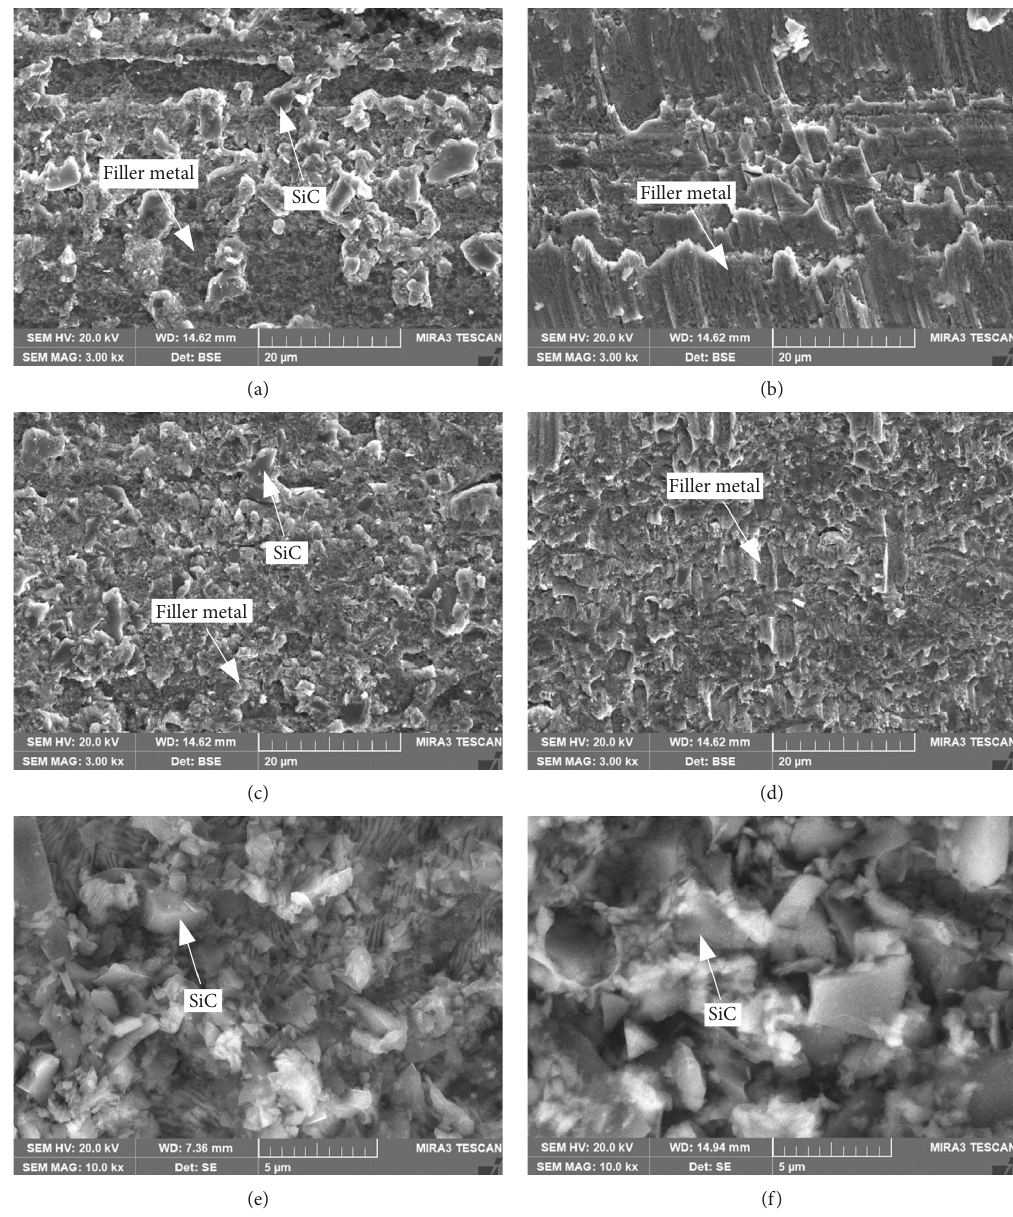
Figure 7: Fracture surface of the joint with 1 μ m SiC particles at (a, b) 1g/m 2 , (c, d) 3 g/m 2 , and (e, f) 4g/m 2